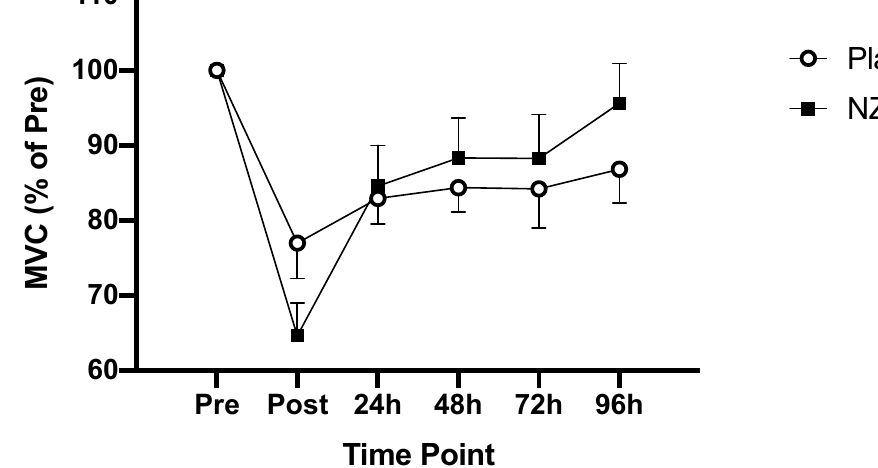
Figure 1. Change in maximal voluntary contraction of the elbow flexor muscles following eccentric exercise (percentage of pre-exercise strength) in the PLA and NZBC groups. Values are means ± SEM.